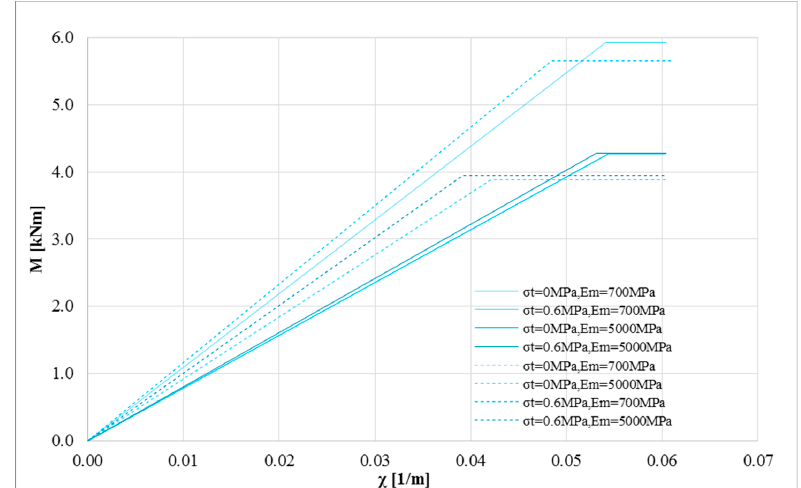
Figure 13 . Bi-linearized M- χ curves: P = 0 N, σ 0 = 8 MPa, σ t = 0 and 0.6 MPa, E m = 700 and 5000 MPa for tri-linear (solid lines) and bi-linear (dotted lines) relationships for the strengthening system (hemp fiber).